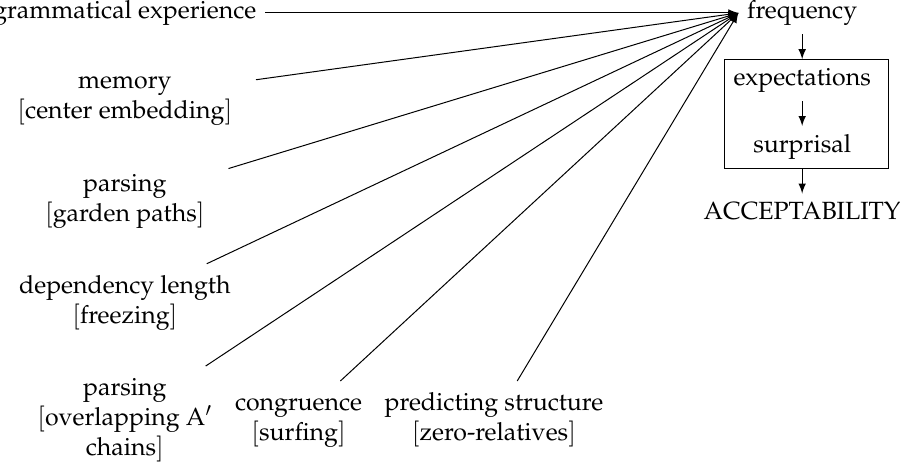
Figure 6. The logic of acceptability judgments for grammatical conditions, version